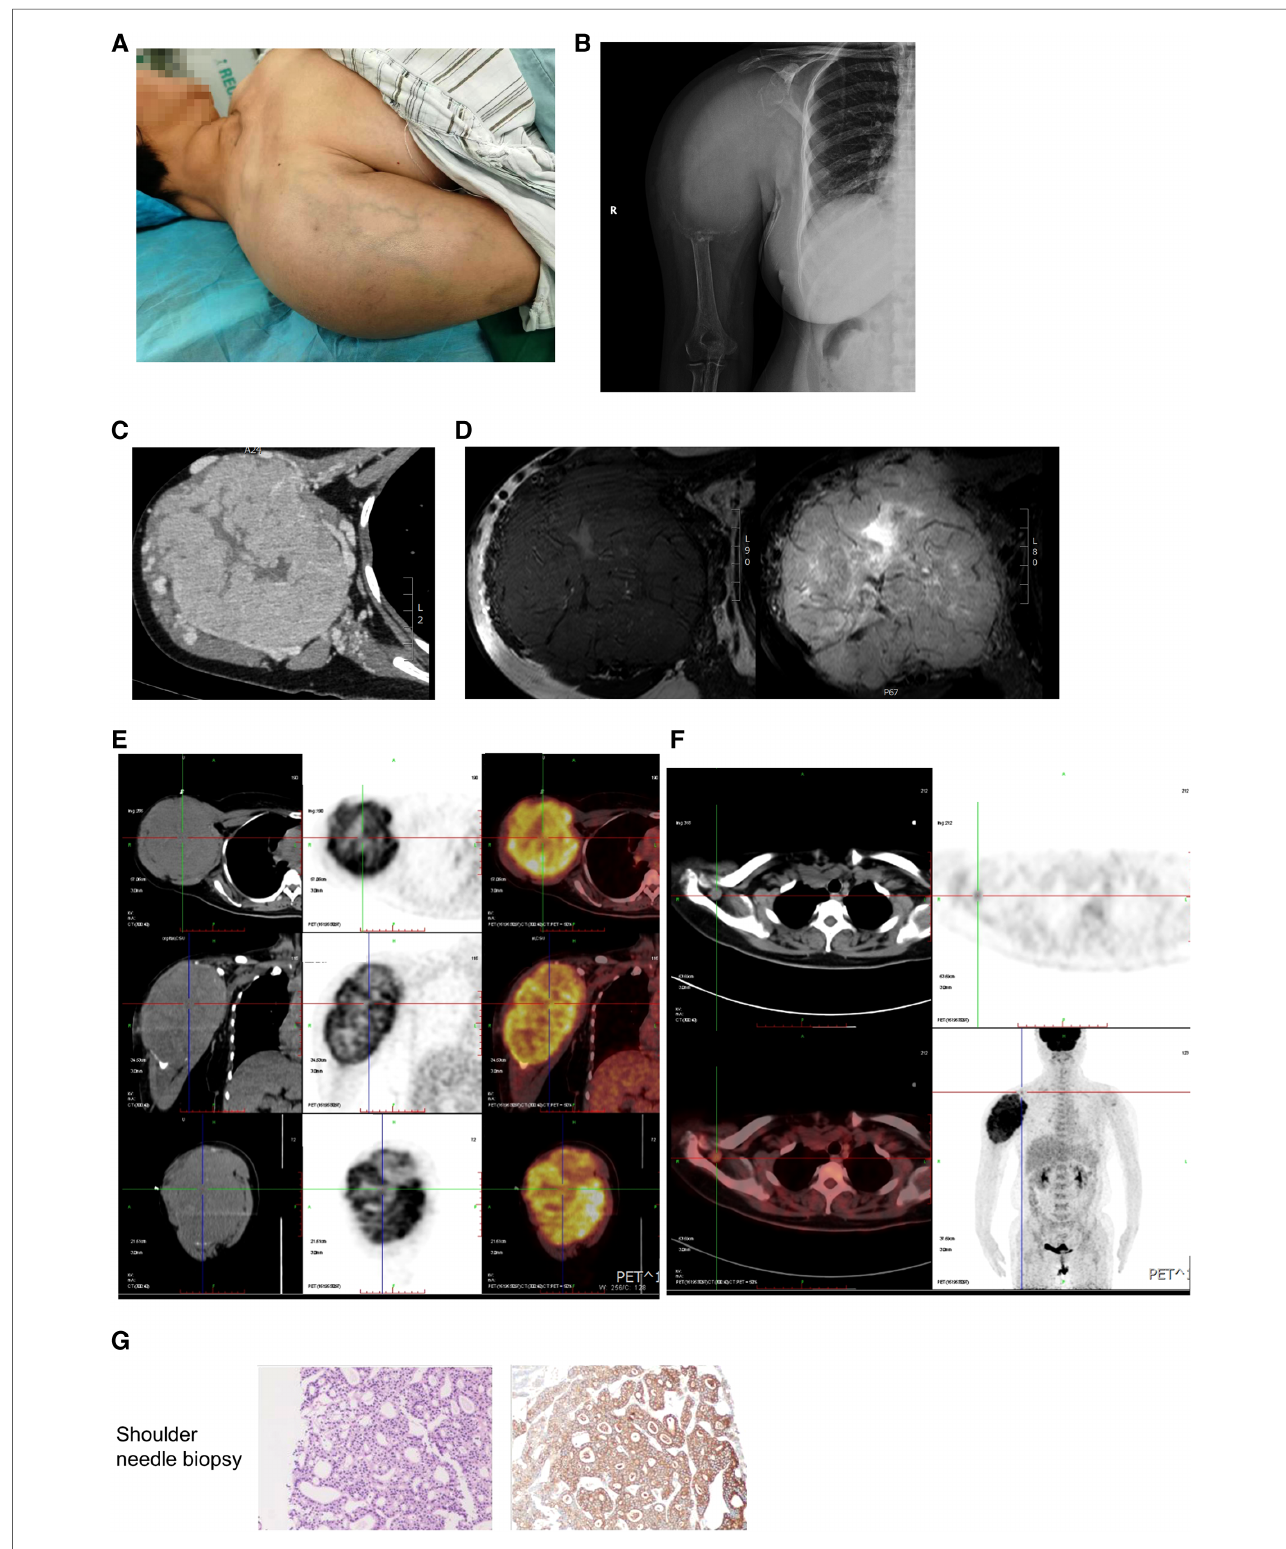
FIGURE 1 Examination and pathology of shoulder tumor. ( A ) The appearance of right shoulder. ( B ) The x-ray of the right humerus showed a vague high-density shadow with unclear boundary, and bone destruction near humerus and scapula. ( C ) Contrast-enhanced CT of the right humerus showed a soft mass replacing the normal bone structure with unclear boundary and dilated blood vessels. ( D ) No normal structure was found in the right humerus, shoulder joint and clavicle by MRI. T1 weighted image shows a mass with low signal intensity. T2 weighted image shows high signal intensity. ( E , F ) 18 F-FDG PET/CT image showed that increased uptake in shoulder tumor ( E ) and the right supraclavicular fossa ( F ). ( G ) Needle biopsy of shoulder